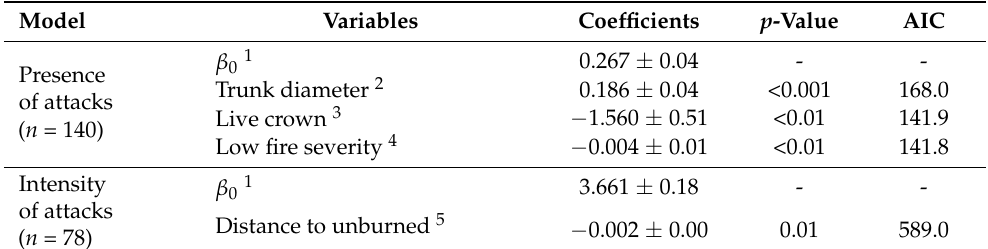
Table 4. Generalized linear models (GLM) showing the variables influencing the presence and intensity of ambrosia beetle attacks in burned cork oaks along a transect crossing the burned area one year following fire (variables are ordered by decreasing order of importance; models based on 140 and 78 trees, respectively). Model Variables Coefficients p -Value AIC